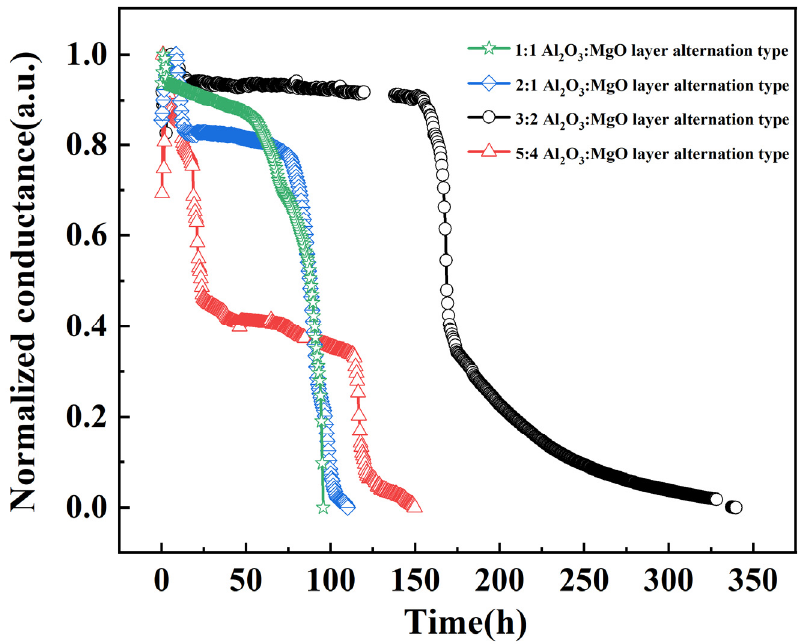
Figure 8. Mg test results of films with different composite structures.